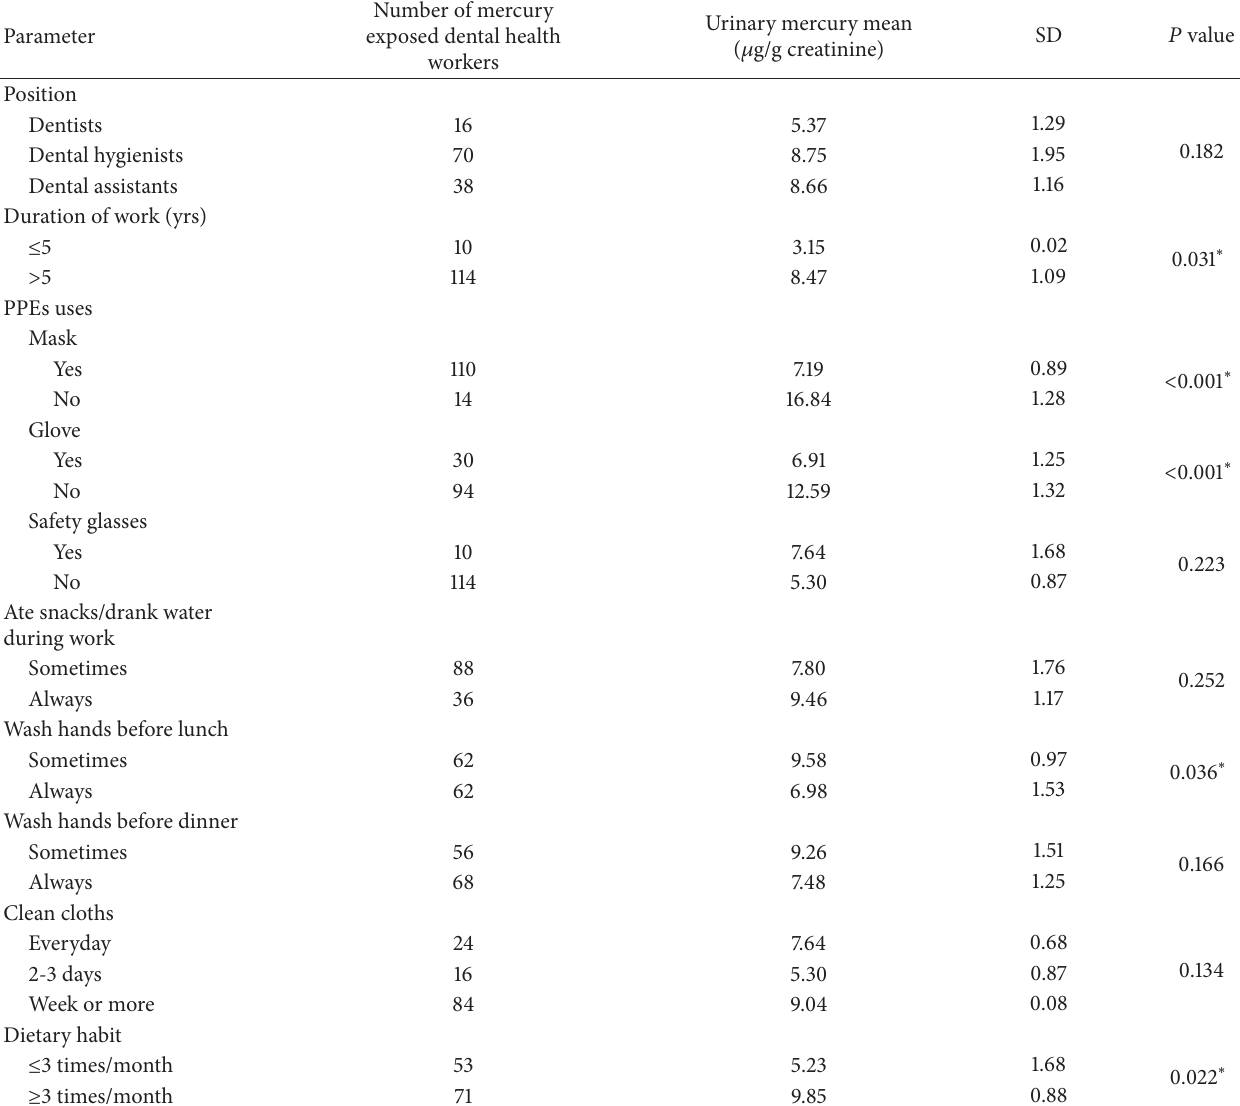
Table 4: Descriptive characteristics of urinary mercury levels, PPEs used, and personal hygiene, behaviors, and dietary habit.